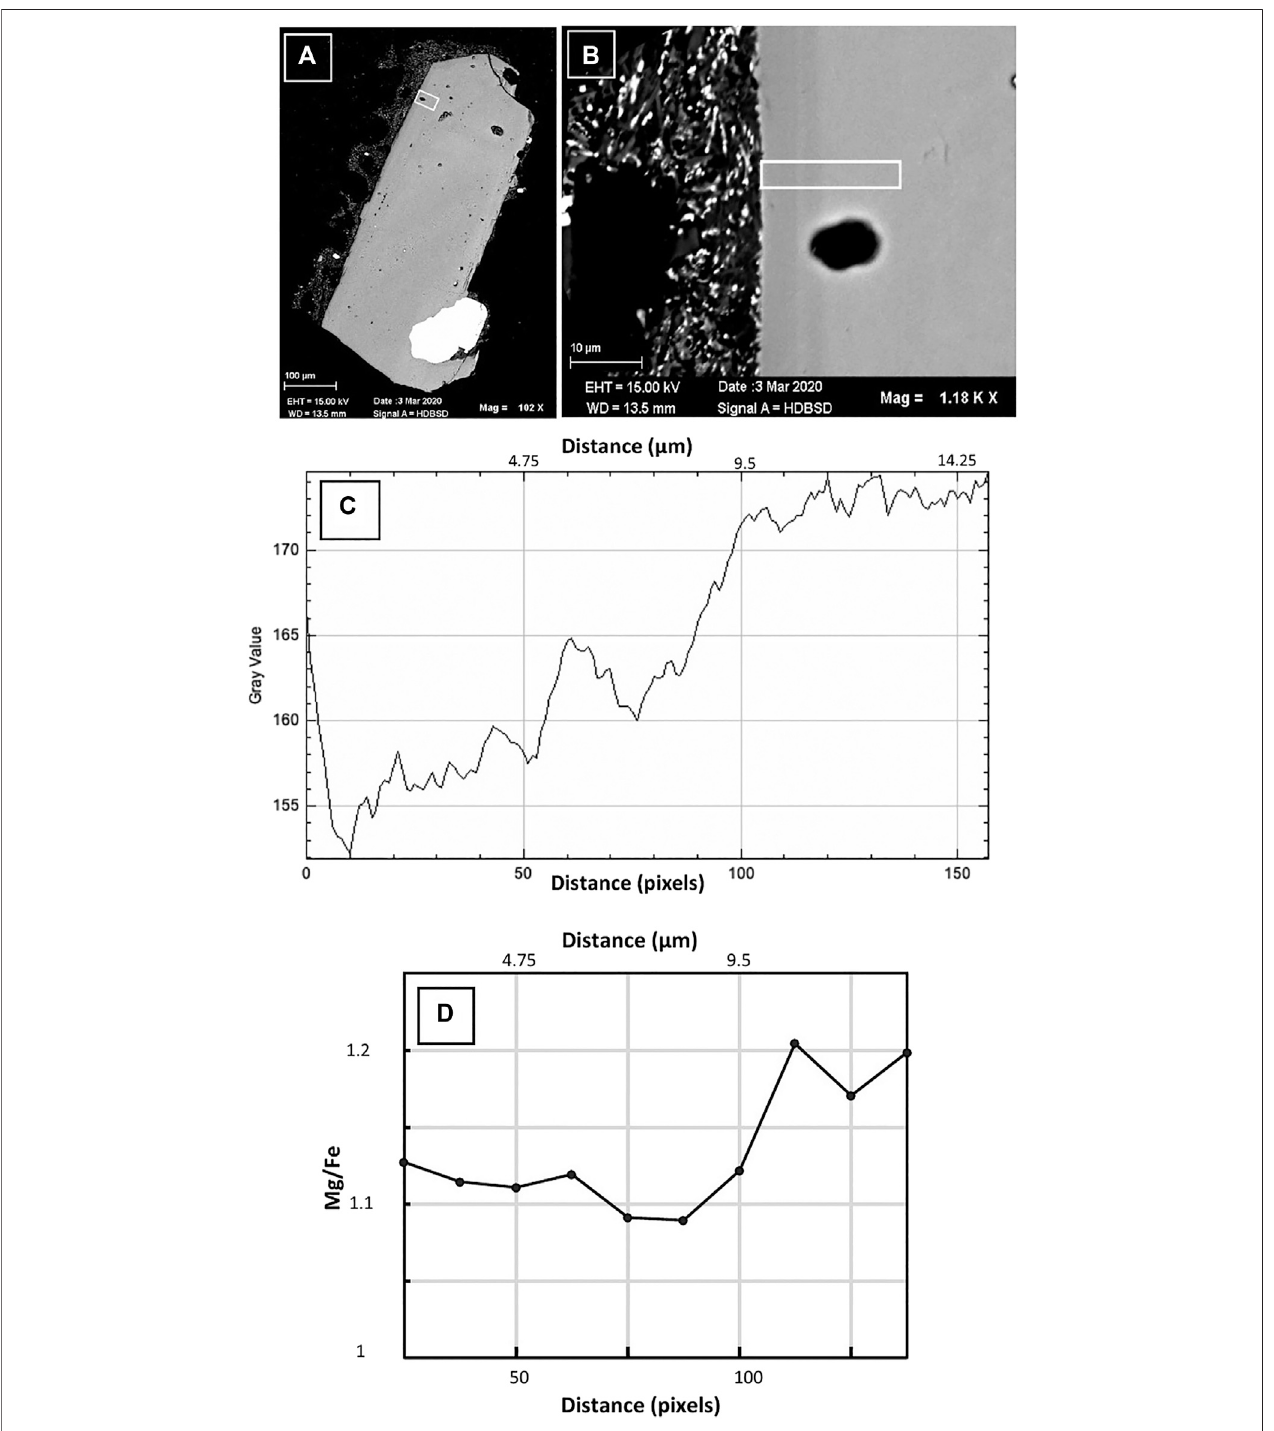
FIGURE 4 | (A) Overview of a crystal from the ∼ 341 Cal. CE eruption, the crystal is euhedral with melt inclusions and large oxide inclusions. (B) Close up of the zoning with the area chosen for diffusion studies shown by the white box. This zone is congruent and on closer inspection this dark zone has a thin, pale zone within it. This may be a result of melt composition variation which results in small changes in the zoning patterns. This is also re fl ected in the ImageJ gray scale pro fi le. (C) Pro fi le produced by ImageJ, a steep decline in greyscale at the boundary of the sharp zone is seen, this then increases again in the separation between the dark zones before decreasing again. The sudden rise in gray value at the end of the pro fi le is an effect of the SEM creating a bright, white rim at the edge of the crystal. (D) EMPA transect across the crystal rim, con fi rming the crystal composition and the correlation between Fe-Mg and greyscale value. A similar shape is observed in both the ImageJ and EMPA pro fi